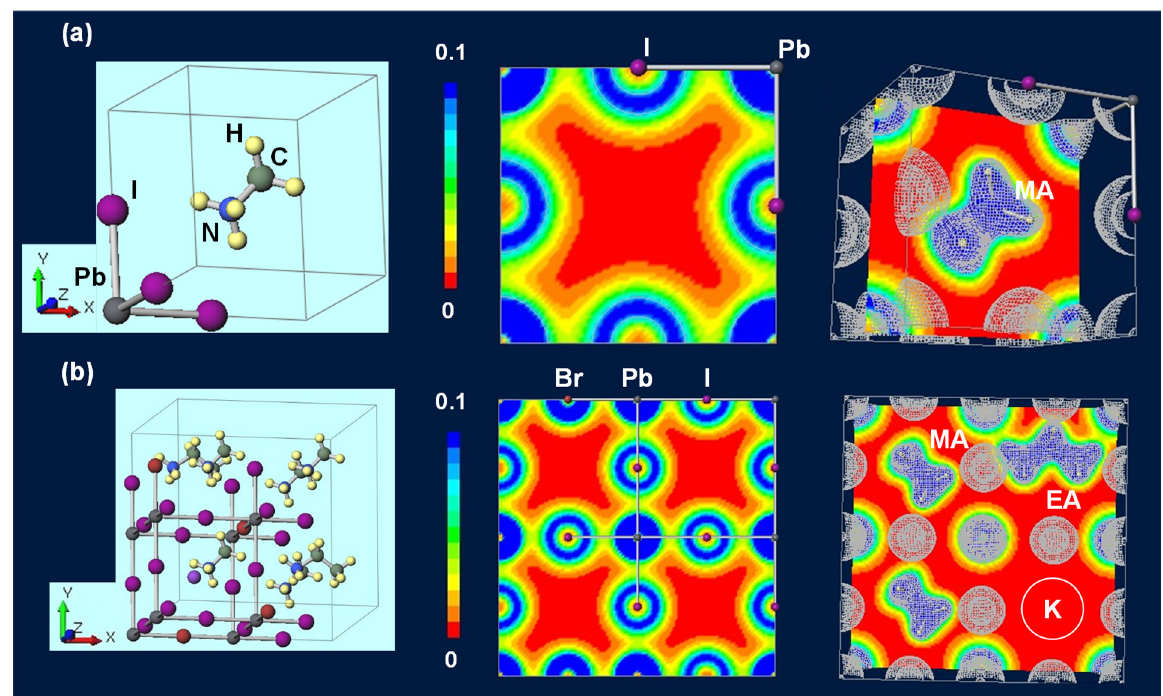
Figure 6. Crystal structures and calculated electron density distributions of ( a ) MAPbI 3 and ( b ) MA 0.625 EA 0.25 K 0.125 PbI 2.5 Br 0.5 .